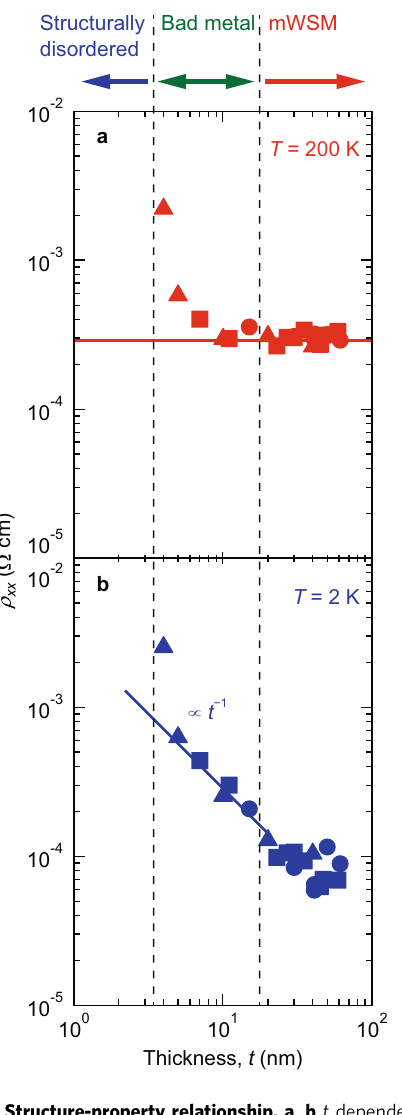
Fig. 2 Structure-property relationship. a , b t dependence of ρ xx at T = 200 K and 2 K, respectively. The symbols in a and b correspond to the used sputtering targets: A (circles), B (triangles) and C (squares). The red solid line in a is a guide to the eye, corresponding to the value of ρ xx bulk = 2.9 × 10 − 4 Ω cm. The blue solid line in b represents a rough relation of ρ / t (cid:2) 1 . These data suggest three t regions with distinct conduction mechanisms: mWSM xx for t > ~15 nm, bad metal without surface conduction for ~3 nm < t < ~15 nm, and structurally disordered islands without electrical connection for t < ~3 nm. c – e Cross-sectional TEM images for t = 45, 10 and 2.7 (nominal) nm, respectively. The t obs values represent rough thicknesses of Co 3 Sn 2 S 2 estimated from the TEM images. f – h M versus μ 0 H curves for t = 41, 10 and 2.7 (nominal) nm, respectively. The used sputtering targets were A for e – h , B for d , and C for c